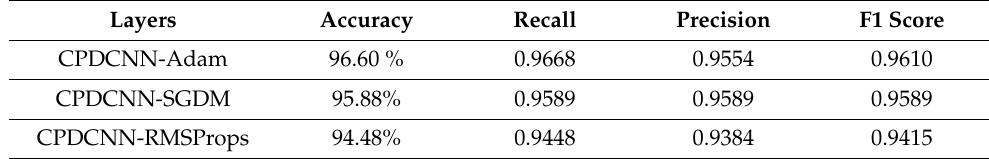
Table 2. Performance of the proposed CPDCNN for different CNN layers.